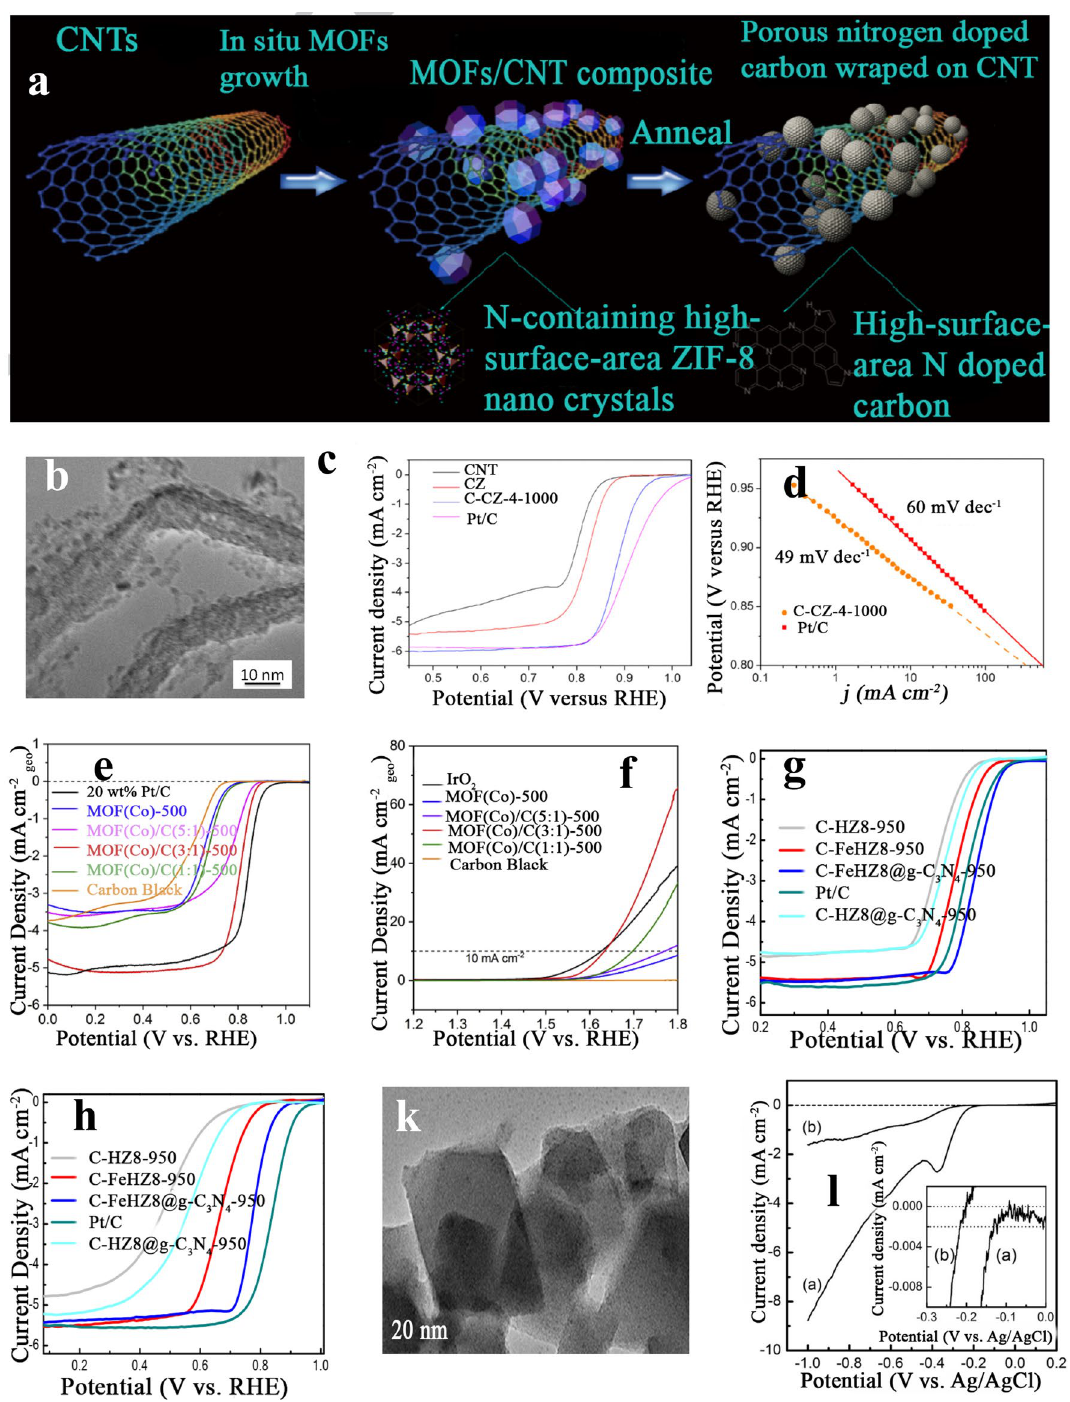
Fig. 6 a Schematic representations for developing high-surface-area N-doped carbon from MOF/CNT composites, b low-magnification TEM image of C-CZ-4-1000, CNT, C-ZIF-1000, c C-CZ-4-1000 (0.72 mg catalyst cm 2 ) and 40 wt% Pt/C electrocatalysts (80 µg Pt cm 2 ) at 1600 rpm in O 2 -saturated 0.1 M KOH at 5 mV s −1 , and d Tafel plots of C-CZ-4-1000 and Pt/C [120], Copyright© 2021, Elsevier. e ORR LSV curves in the O2-saturated 0.1 M KOH at 1600 rpm with a scan rate of 5 mV s −1 and f OER LSV curves at 1600 rpm at a scan rate of 5 mV s −1 in O2-saturated 0.1 M KOH [135], Copyright© 2019, Elsevier. g LSV curves of C-HZ8-950, C-HZ8@g-C3N4-950, C-FeHZ8-950, C-FeHZ8@g- C3N4-950, and 20 wt% Pt/C in h O2-saturated 0.1 M KOH and 0.1 M HClO4 (rotation rate: 1600 rpm) [79], Copyright© 2019, The Royal Society of Chemistry. k TEM images of the MOF(Fe/Co) sample and l ORR activities of the samples: ( a ) MOF(Fe/Co) + SP and ( b ) SP [143], Copyright © 2014,